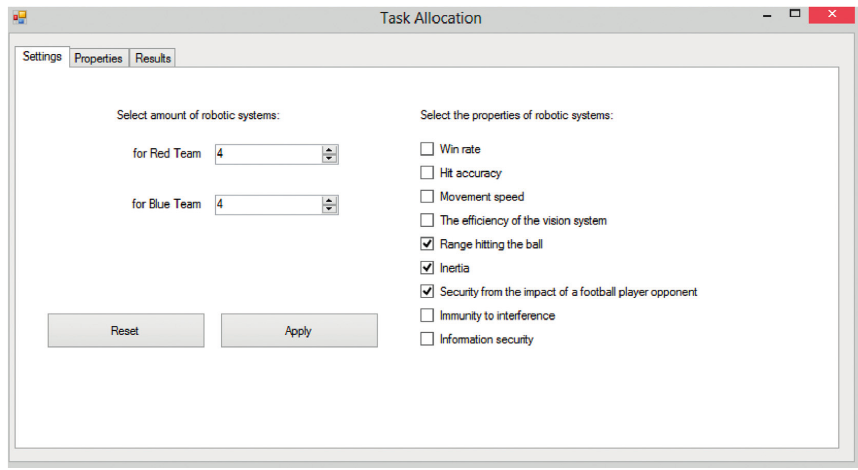
Figure 8: Selected robotics